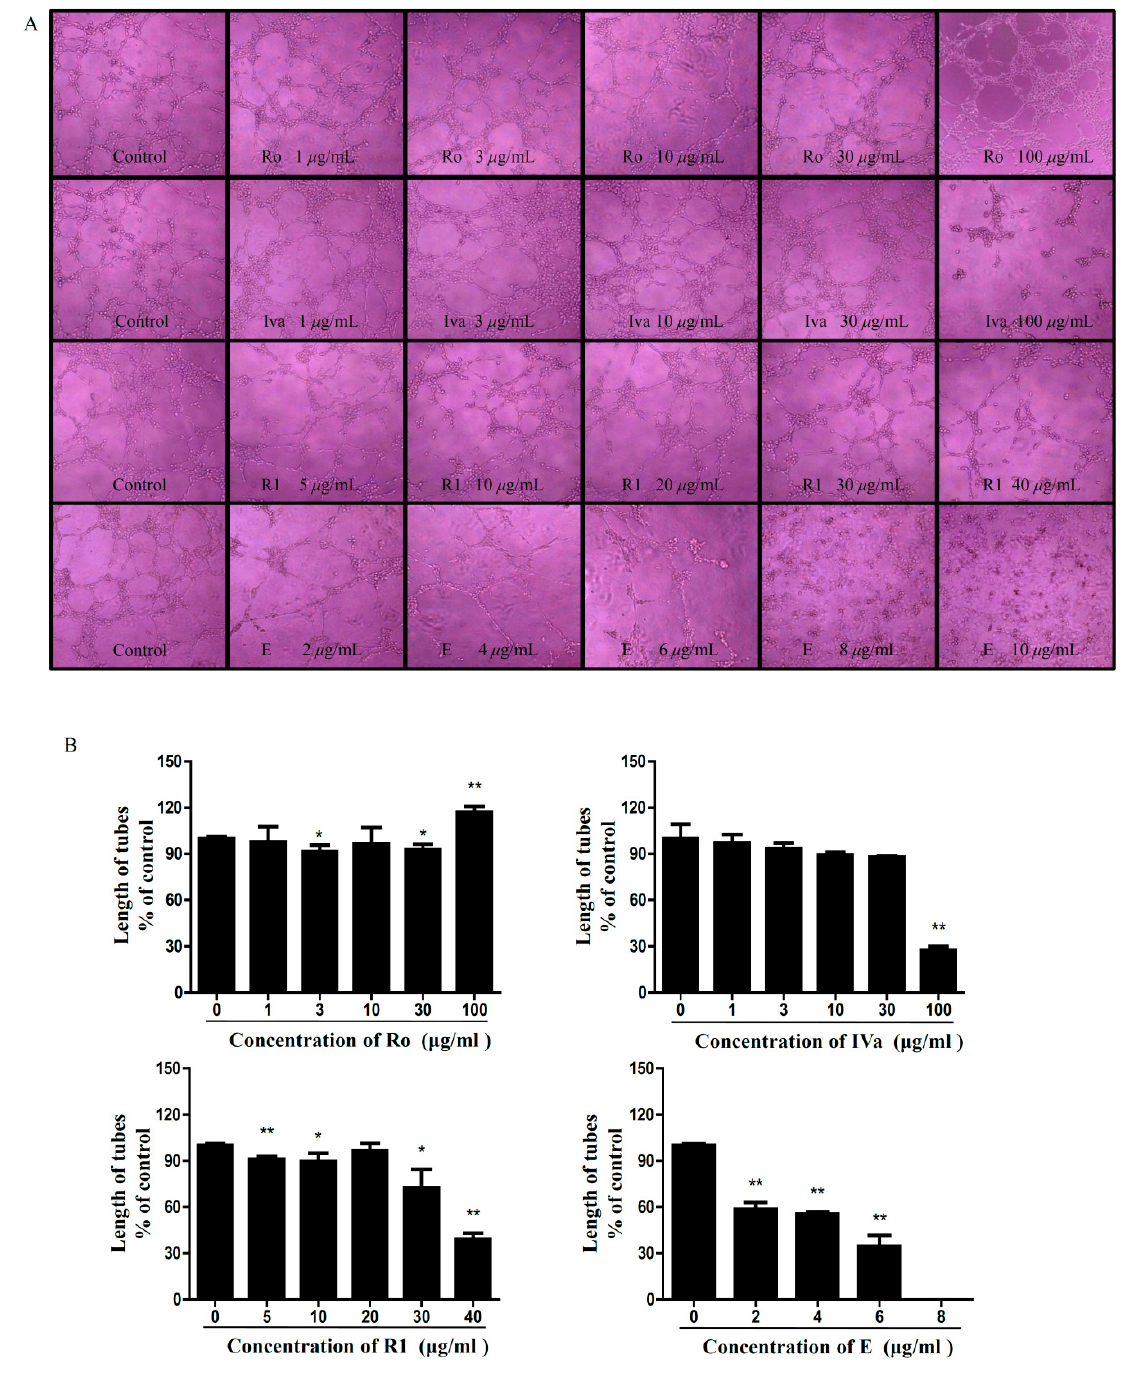
Figure 8. Results of tube formation. ( A ) The human umbilical vein endothelial cells (HUVECs) tubular structures were imaged under a microscope at 100 × magnification. ( B ) Tube networks were quantified using Image-Pro Plus 6.0 software (Media Cybernetics, Silver Spring, MD, USA). The tube length was calculated (* p < 0.05, ** p < 0.01).